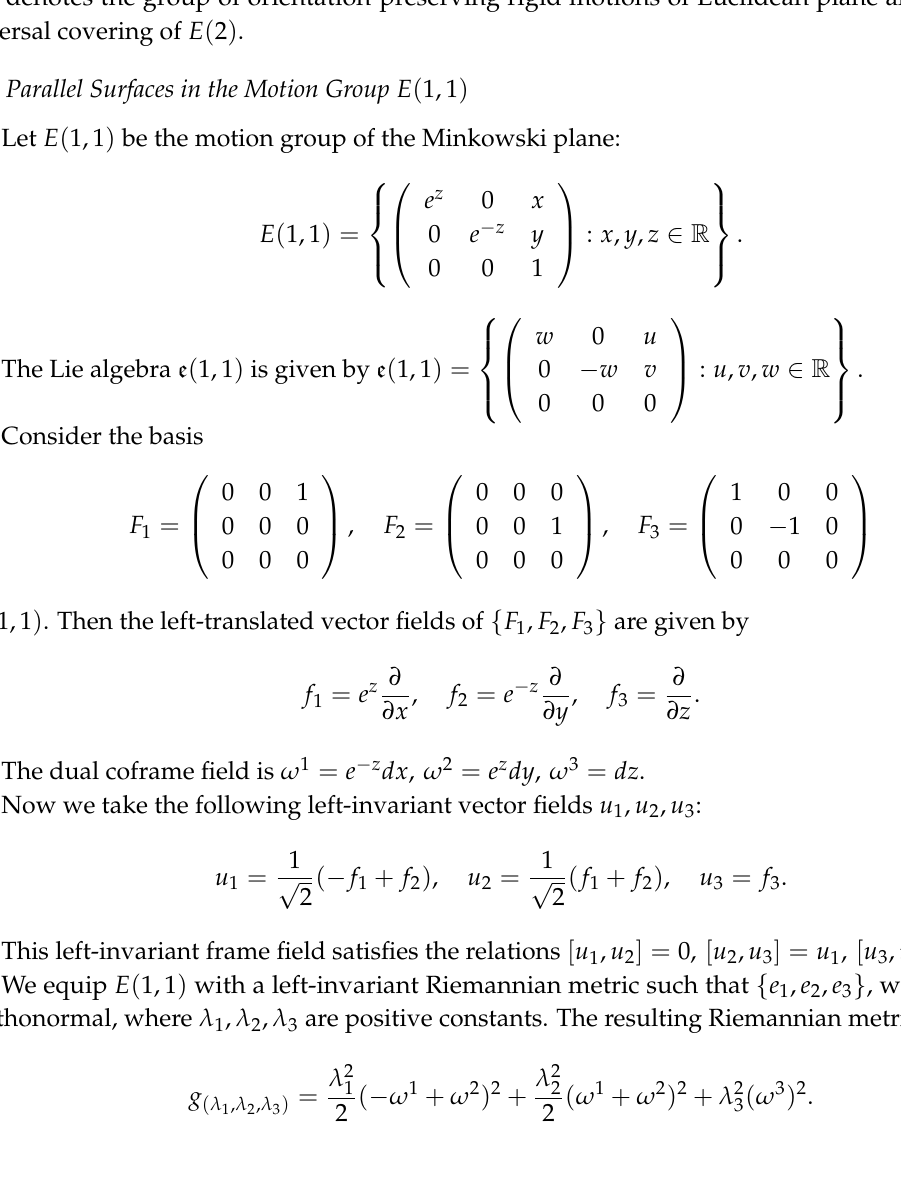
Table 1. Three-dimensional unimodular Lie groups classified by J. Milnor. ( c 1 , c 2 , c 3 ) Simply-Connected Lie Group Property (+ , + , +) SU ( 2 ) Compact and simple (+ , + , − ) (cid:102) SL ( 2, R ) Non-compact and simple (+ , + ,0 ) ˜ E ( 2 ) Solvable (+ , − ,0 ) E ( 1,1 ) Solvable (+ ,0,0 ) Heisenberg group Nilpotent ( 0,0,0 ) ( E 3 , +)